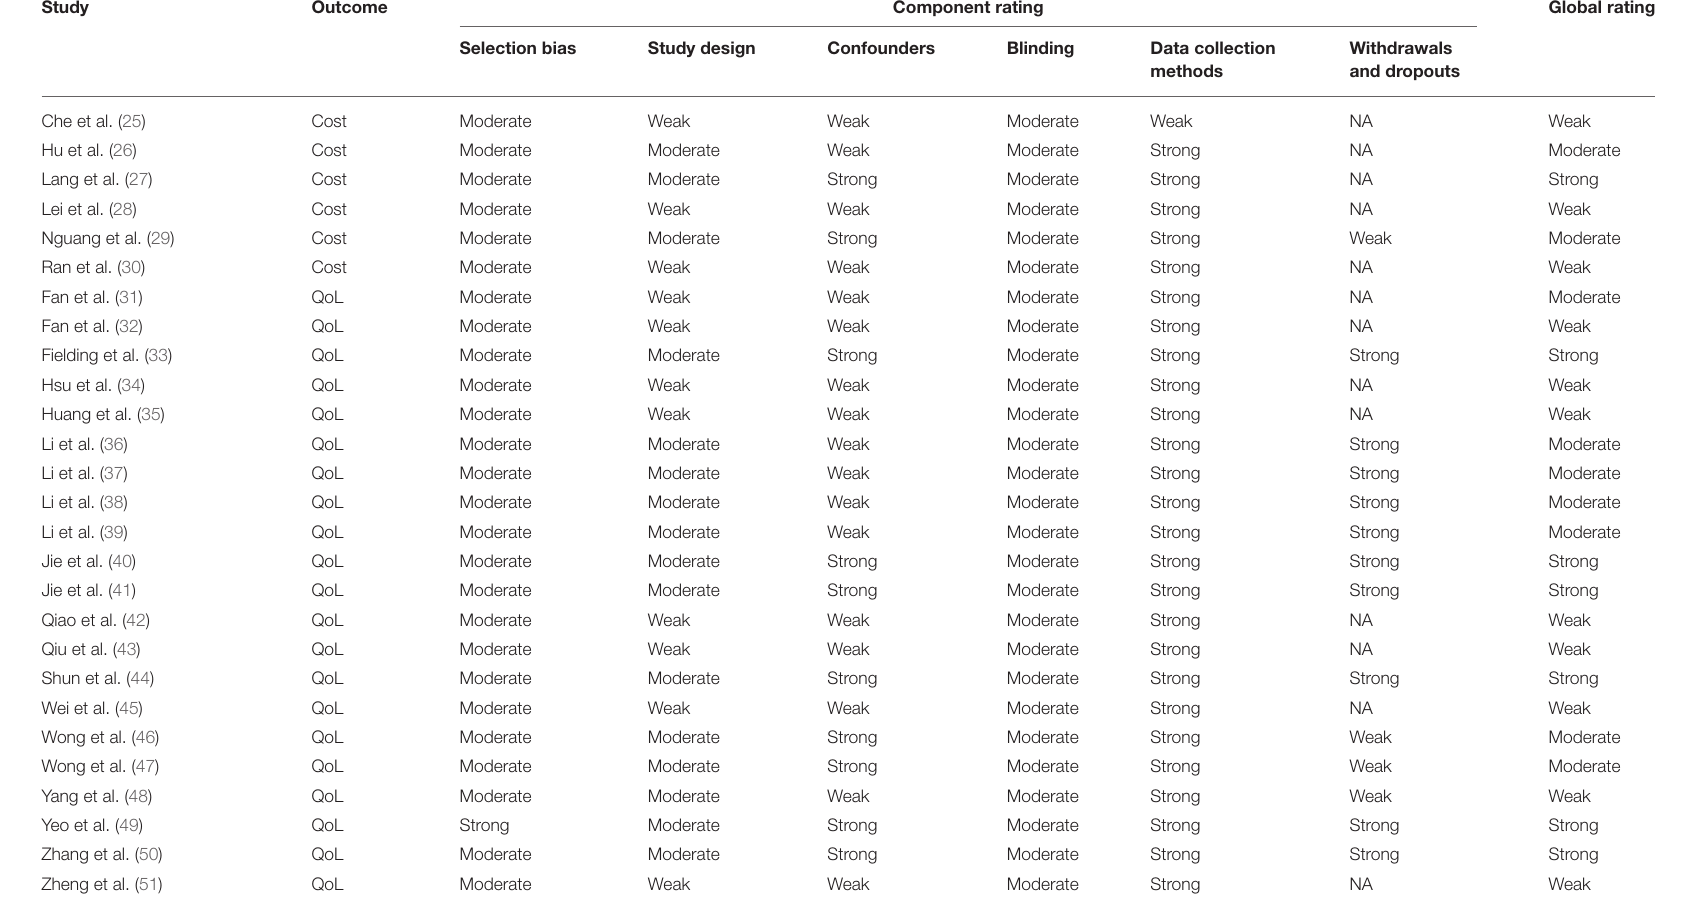
TABLE 2 | Quality assessment of identified